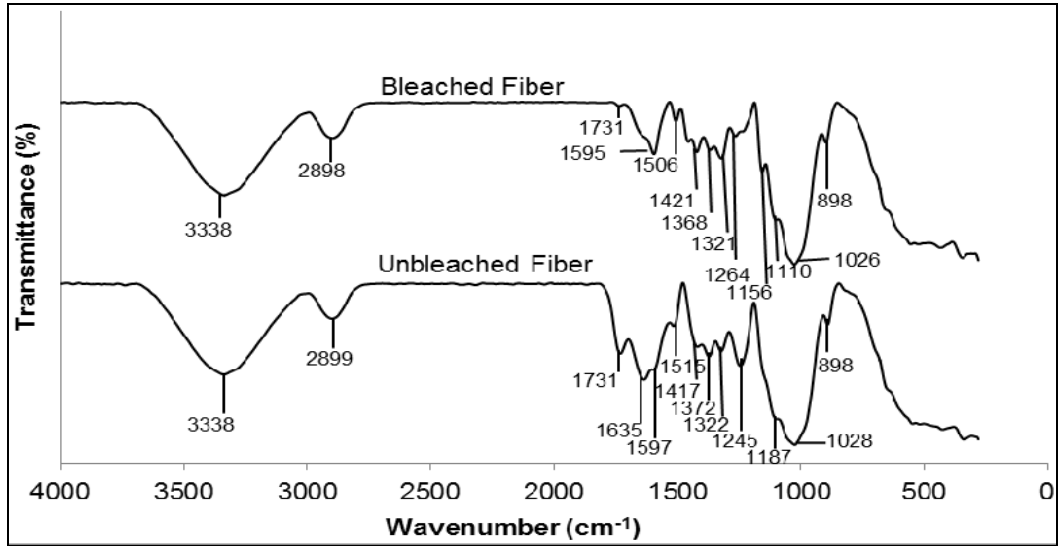
Figure 2. FTIR spectra of bleached and unbleached kenaf